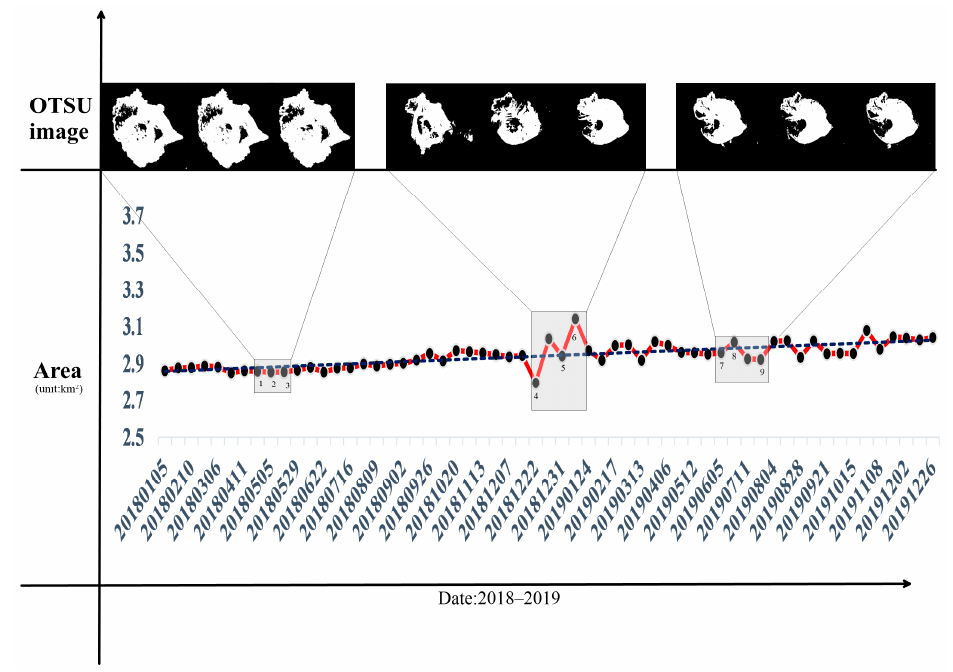
Figure 5. The change of volcanic area from 2018 to 2019 and the comparison of OTSU images and SDWI images at different stages. 1, 2, 3 represent the images of 20180423, 20180505, 20180529, respectively; 4, 5, 6 represent the images of 20181222, 20181227, 20910112; 7, 8, 9 represent the images of 20190629, 20190711, 20190804.